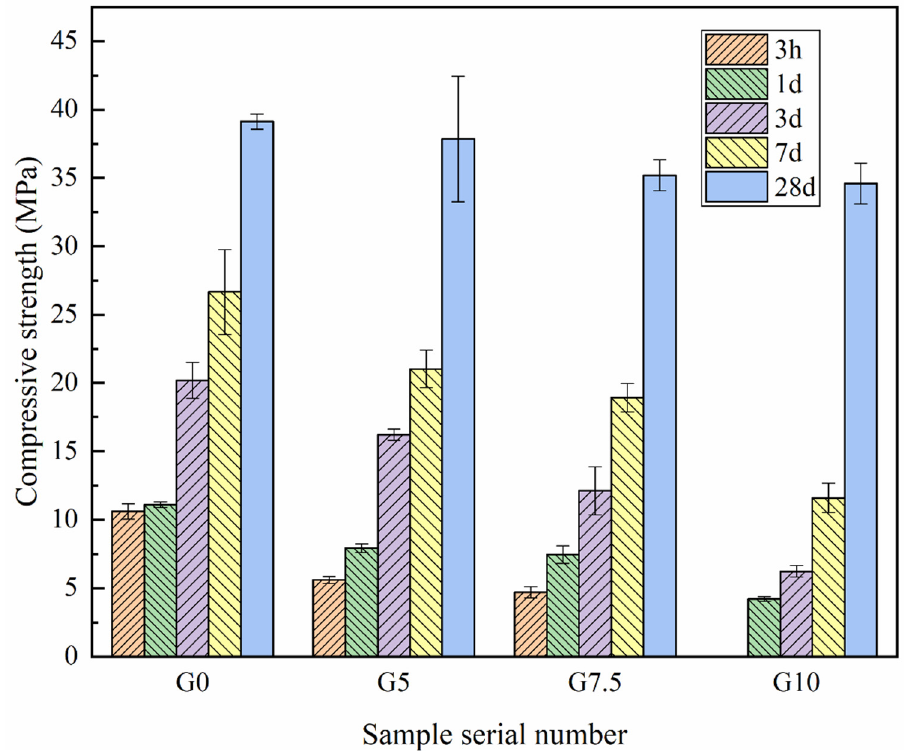
Figure 6. E ff ect of di ff erent water glass contents on compressive strength of MPC at − 5 °C temperature. Figure 6. Effect of different water glass contents on compressive strength of MPC at − 5 ◦ C